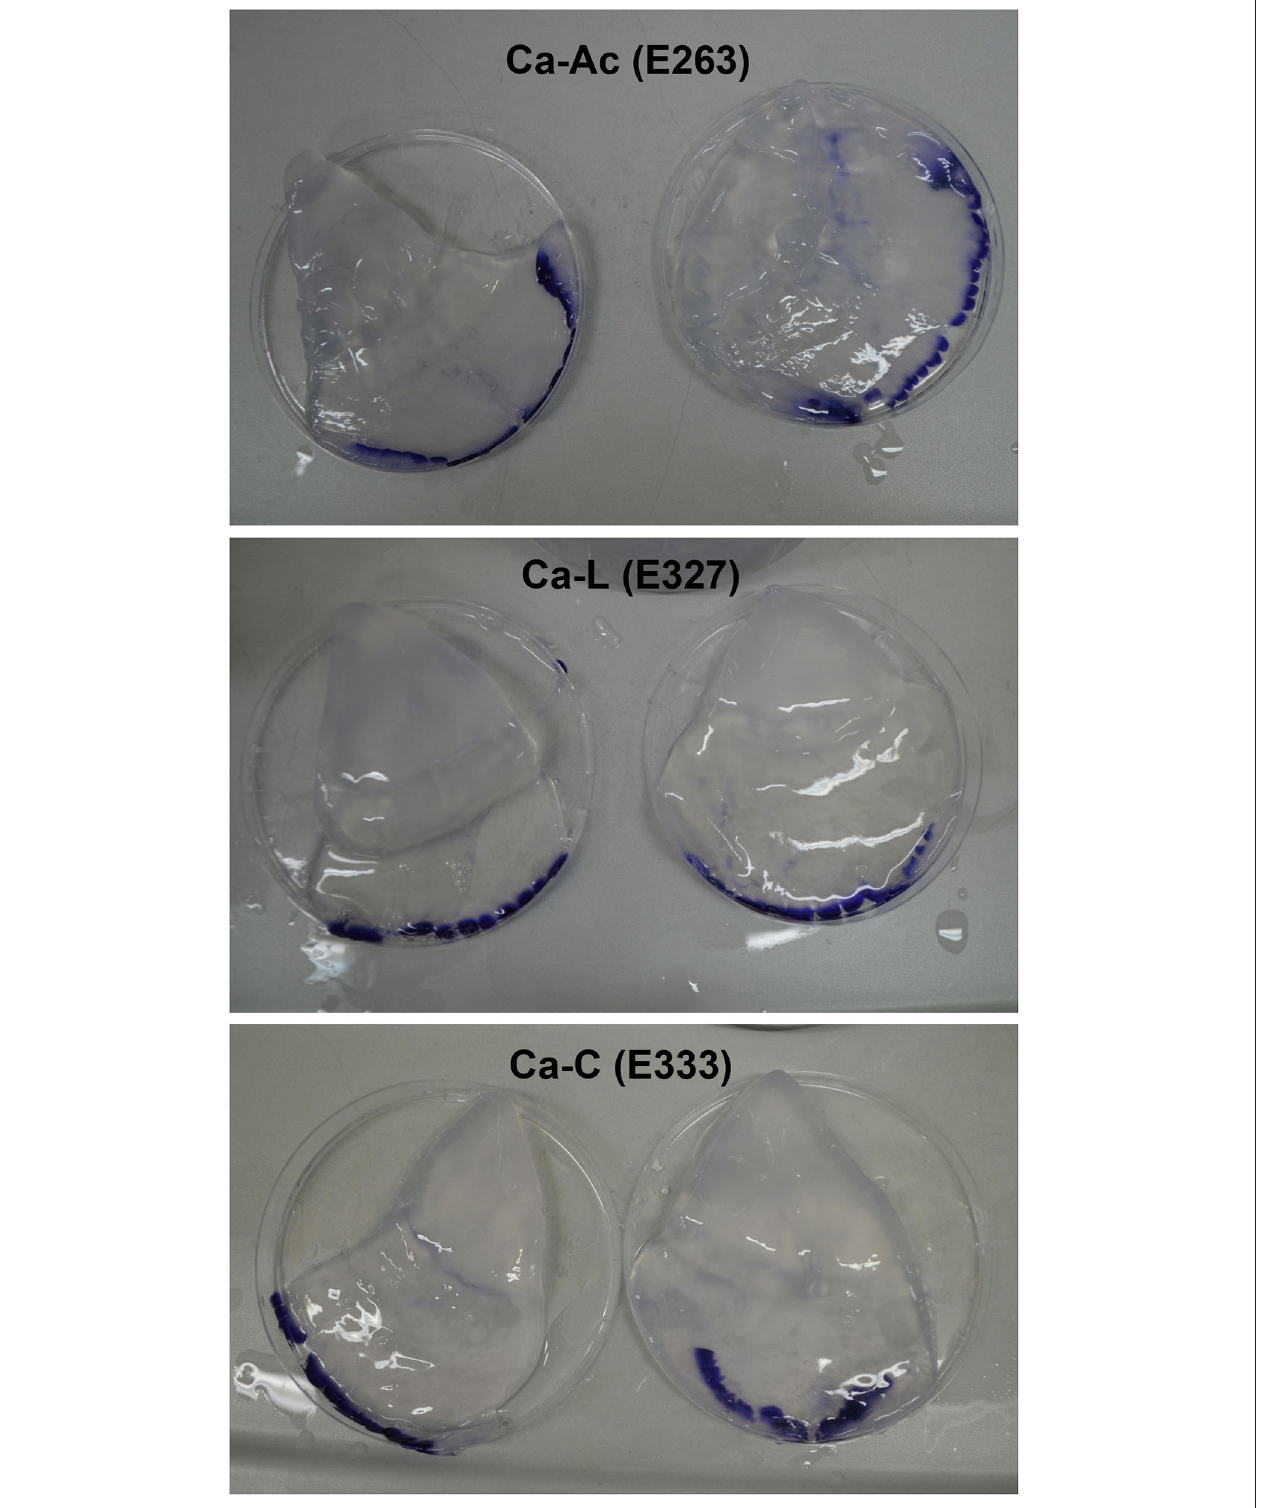
FIGURE 1 | Jellyfish products obtained by the new proposed method using calcium salts as thickening and stabilizing agents. Ca-Ac, calcium acetate; Ca-L, calcium lactate; Ca-C, calcium citrate.